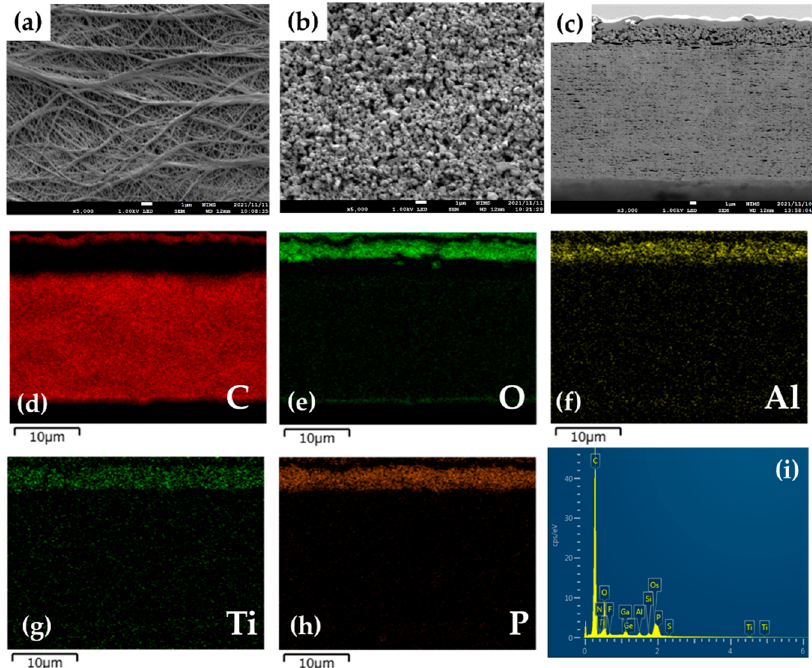
Figure 1. SEM and EDS images of the PE separator with and without coating. Surface SEM images of ( a ) the as-provided PE separator and ( b ) the LICGC/PEO/LiTFSI-coated PE separator. ( c ) Cross-sectional SEM image of the LICGC/PEO/LiTFSI-PE separator. ( d – i ) EDS mapping of the LICGC/PEO/LiTFSI-PE separator.